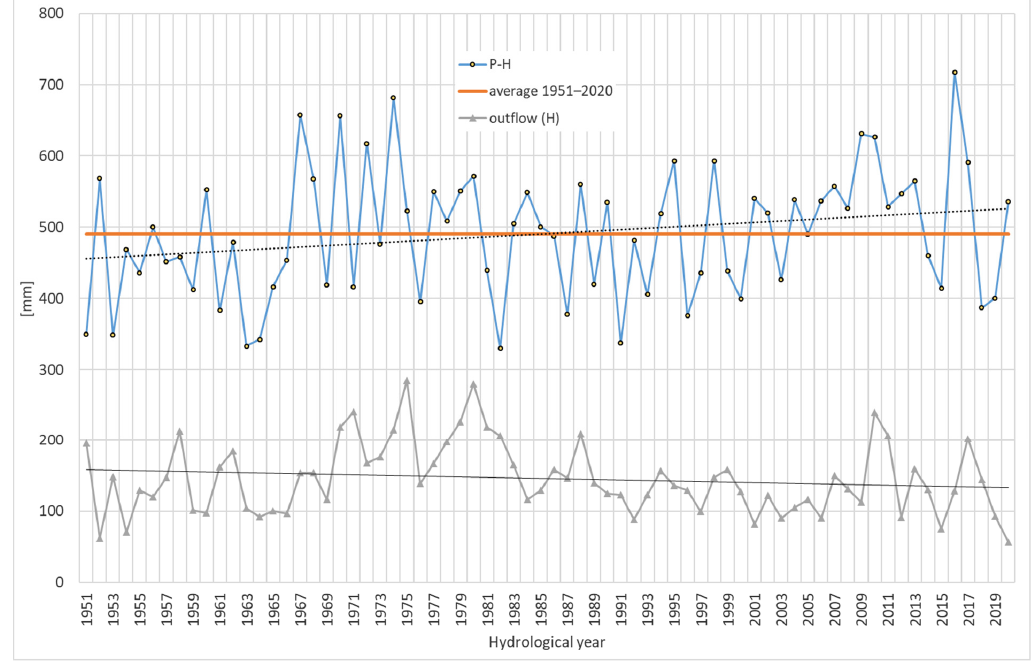
Figure 10. The outflow (H) and value (P–H) (mm) in the period of 1951–2020 at the Narewka gauging station.